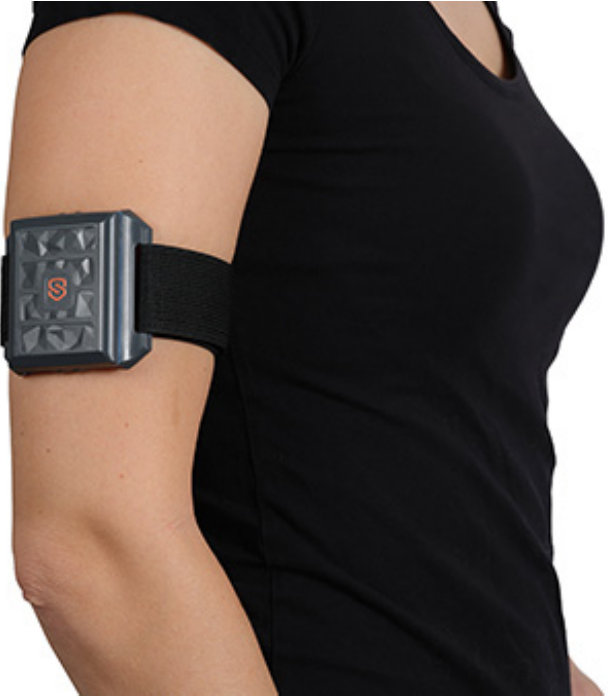
Figure 1. Picture of Slate Safety sensor on participant [31].